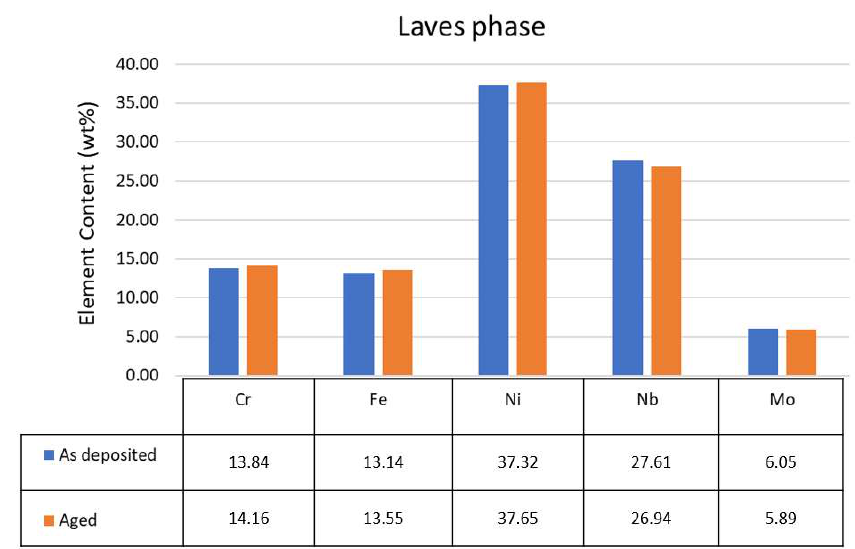
Figure 15. Comparison of Laves phase in the as-deposited and aged samples.